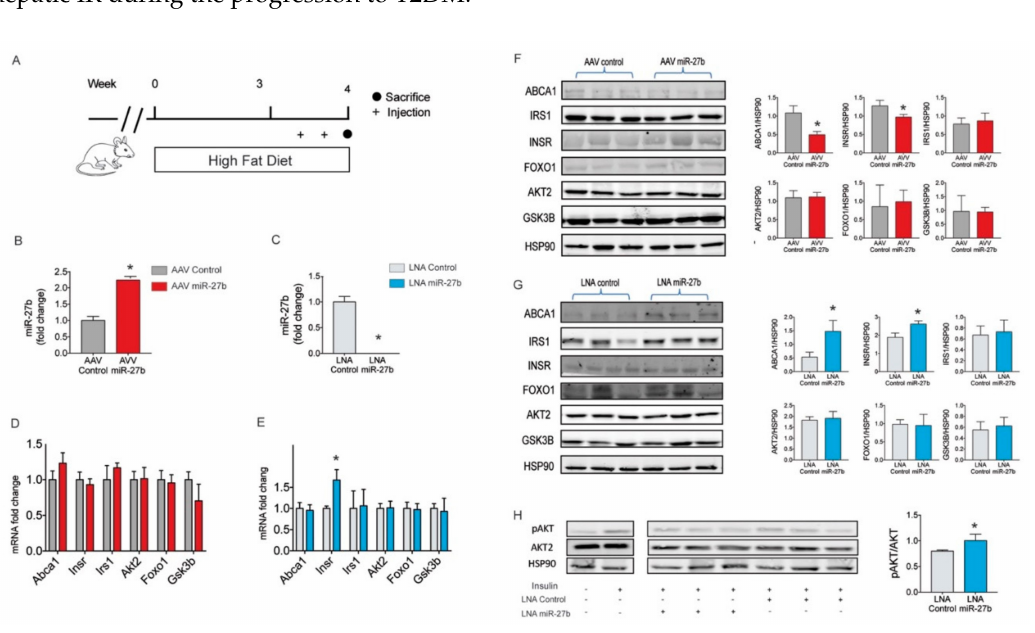
Figure 4. miR-27b modulation a ff ects insulin signaling in wild type mice: ( A ) schematic representation of mice treatment; ( B , C ) miR-27b levels in wild type mice treated with ( B ) null AAV or AAV miR-27b or ( C ) LNA control or LNA miR-27b inhibitor; ( D , E ) mRNA expression of Abca1, Insr, Irs1, Akt2, Foxo1 and Gsk3 β in wild type mice treated with ( D ) null AAV or AAV miR-27b or ( E ) LNA control or LNA